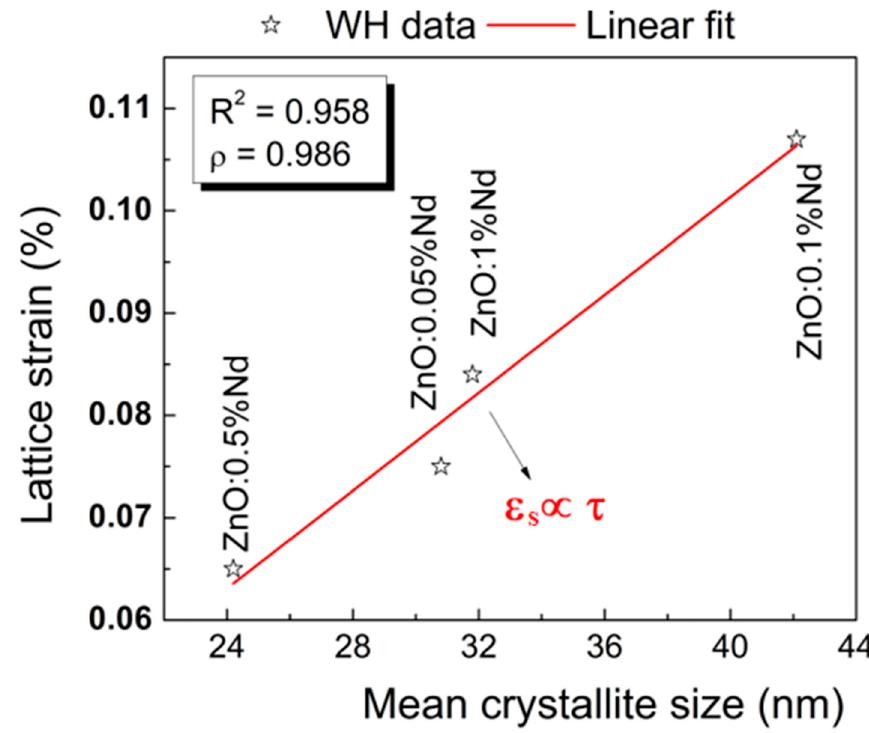
Figure 3. Approximation of the linear fit between lattice strain and mean crystallite size for the doped ZnO samples.